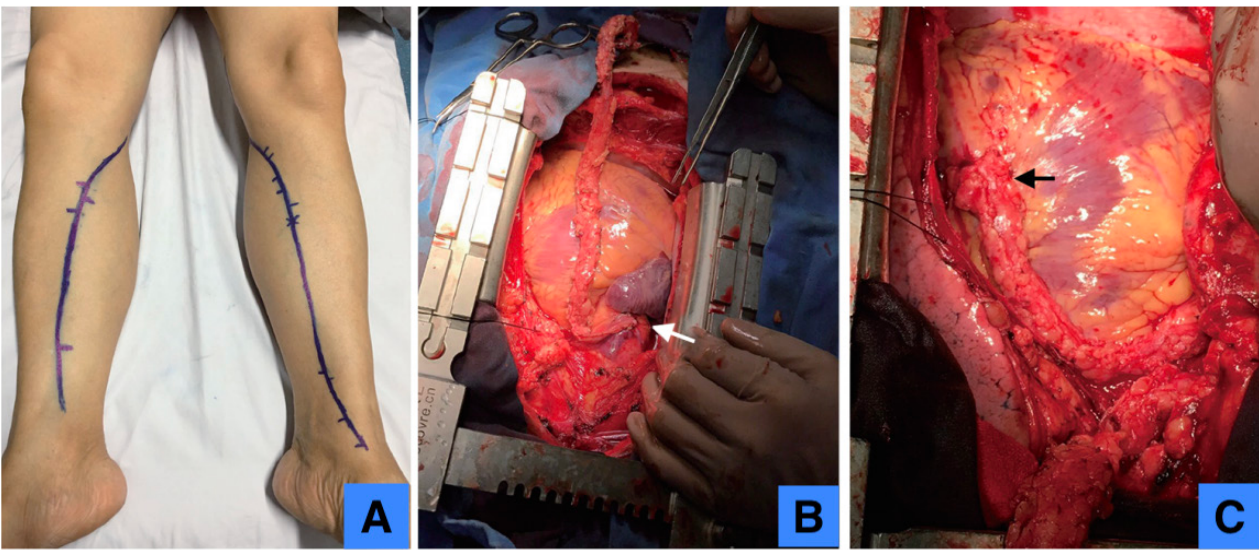
Fig. 2 - (A) Preoperative ultrasonography mapping for lower leg saphenous vein; (B) anastomosis between aorta and no-touch saphenous vein; (C) anastomosis between no-touch saphenous vein and target coronary